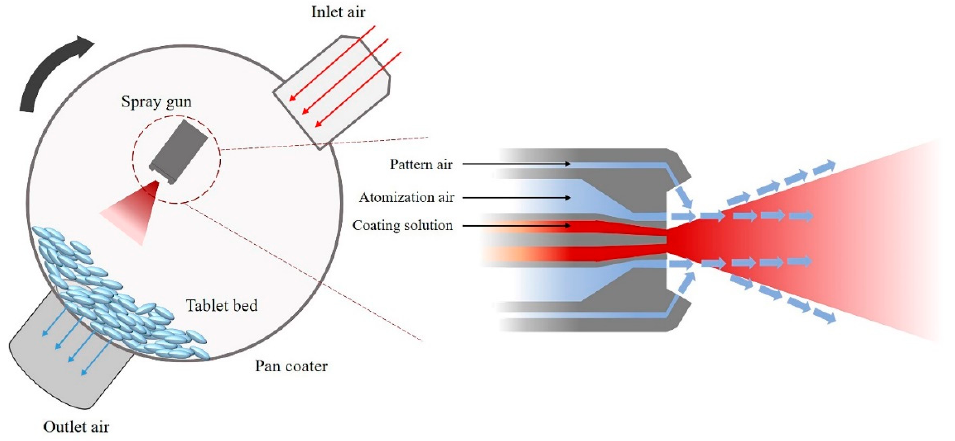
Figure 1. Simplified illustration of a coating pan.